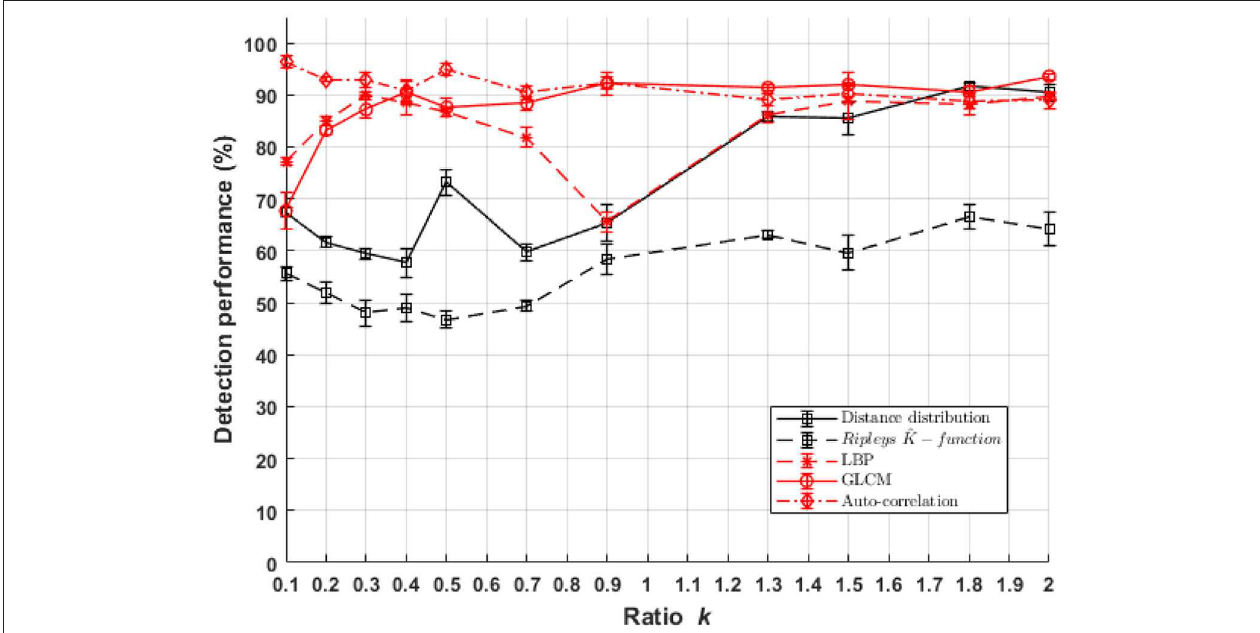
FIGURE 7 | Performance of binary classification for marker density difference between cell classes C 1 and C 2 as a function of parameter k of Equation (1) for both textural and pointillist approaches. The higher k the smaller the PSF size. Standard deviation of performances are computed using 10-folds cross-validation method. In red, methods following the textural approach, and in black, methods following a pointillist